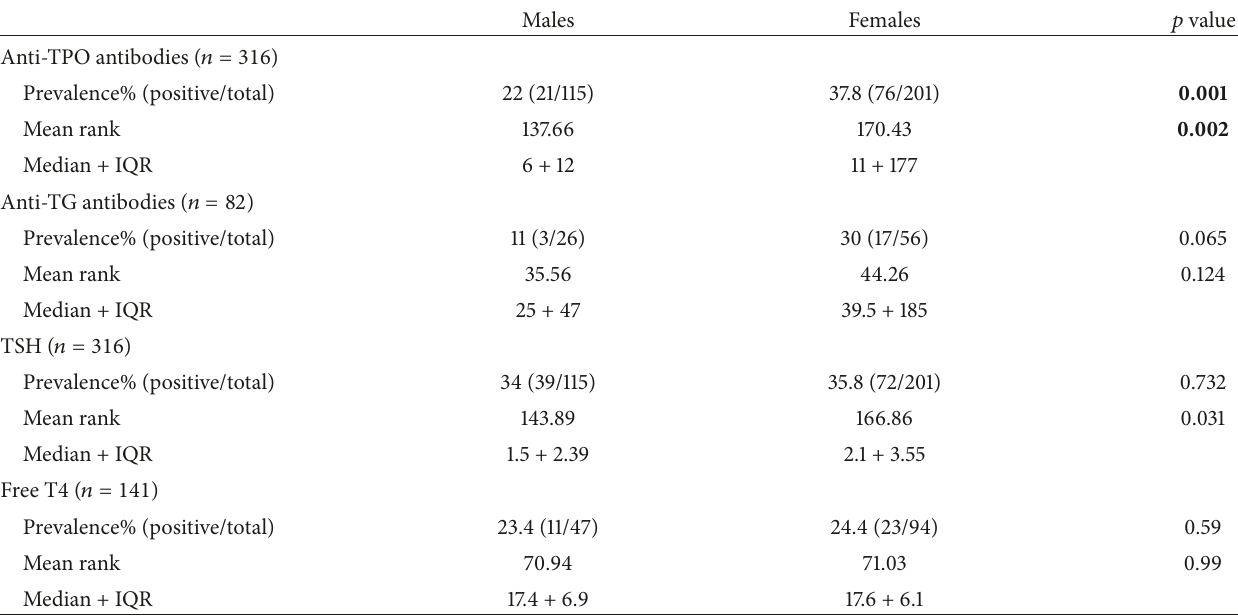
Table 1: Comparison of prevalence (Chi square test) and mean ranks (Mann–Whitney 𝑈 test) for analyzed variables (anti-TPO antibodies, anti-TG antibodies, TSH, and free T4) among males and females. Males